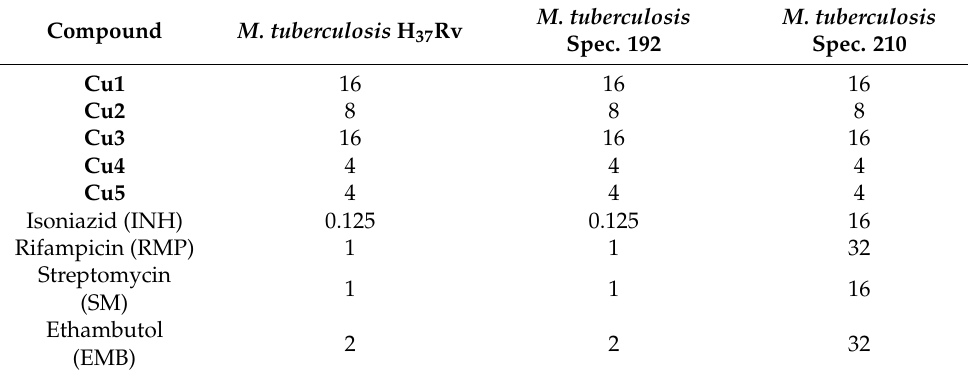
Table 6. Activity of complexes Cu1 – Cu5 against Mycobacterium tuberculosis strains—minimal in- hibitory concentrations (MIC, µ g/mL).